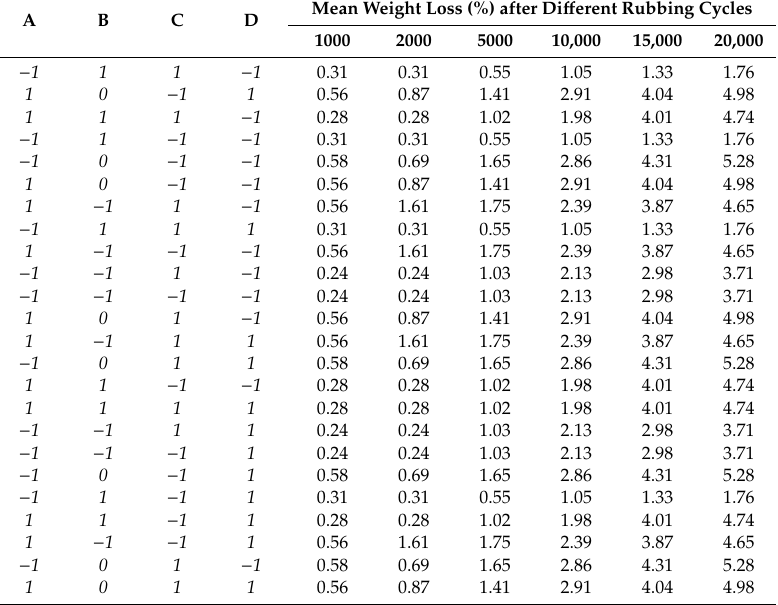
Table A1. Mean weight loss (%) after di ff erent rubbing cycles: 1000, 2000, 5000, 10,000, 15,000 and 20,000. A, B, C and D are the pattern, the weft density, the fabric orientation and the printing bed temperature,